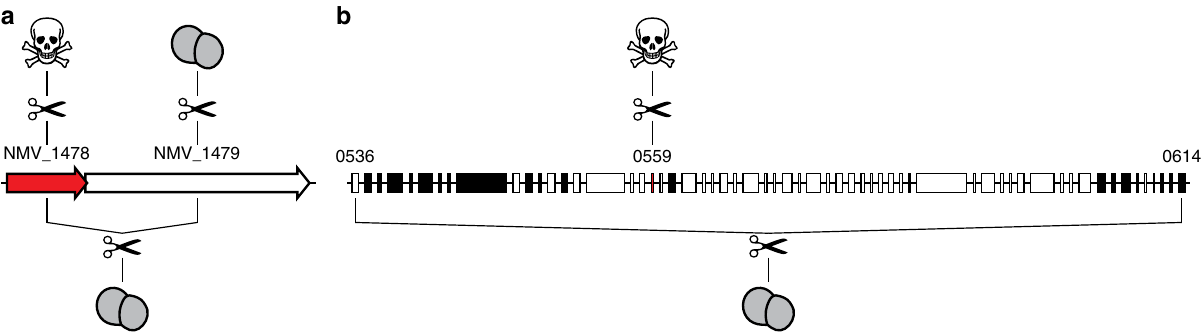
Fig. 5 Essential genes in RGP — NMV_1479 and NMV_0559 — are conditionally essential. a Gene organisation of the putative antitoxin NMV_1478 (highlighted in red) with its neighbouring NMV_1479 toxin. Results of the mutagenesis (represented by scissors) are shown. Viable mutant (represented by a grey diplococcus); lethal phenotype (represented by a skull). b Gene organisation of the tps RGP (RGP_0) to which NMV_0559 (highlighted in red) belongs (Supplementary Data 9). Genes on the + strand are in white, genes on the — strand are in black. Results of the mutagenesis (scissors) are shown. Viable mutant (grey diplococcus); lethal phenotype (skull). In contrast to NMV_0559, each of the other target genes in the tps RGP could be mutated individually (not shown for